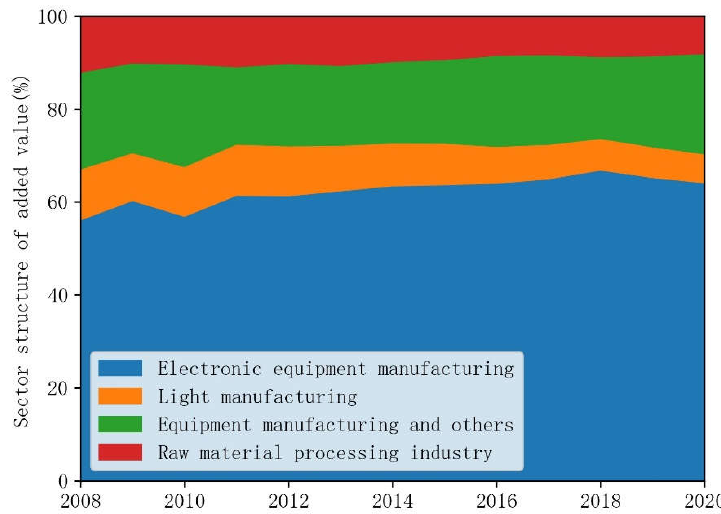
Figure 6. Proportion trend of added value of Shenzhen’s manufacturing sector by four categories during 2008–2020 .